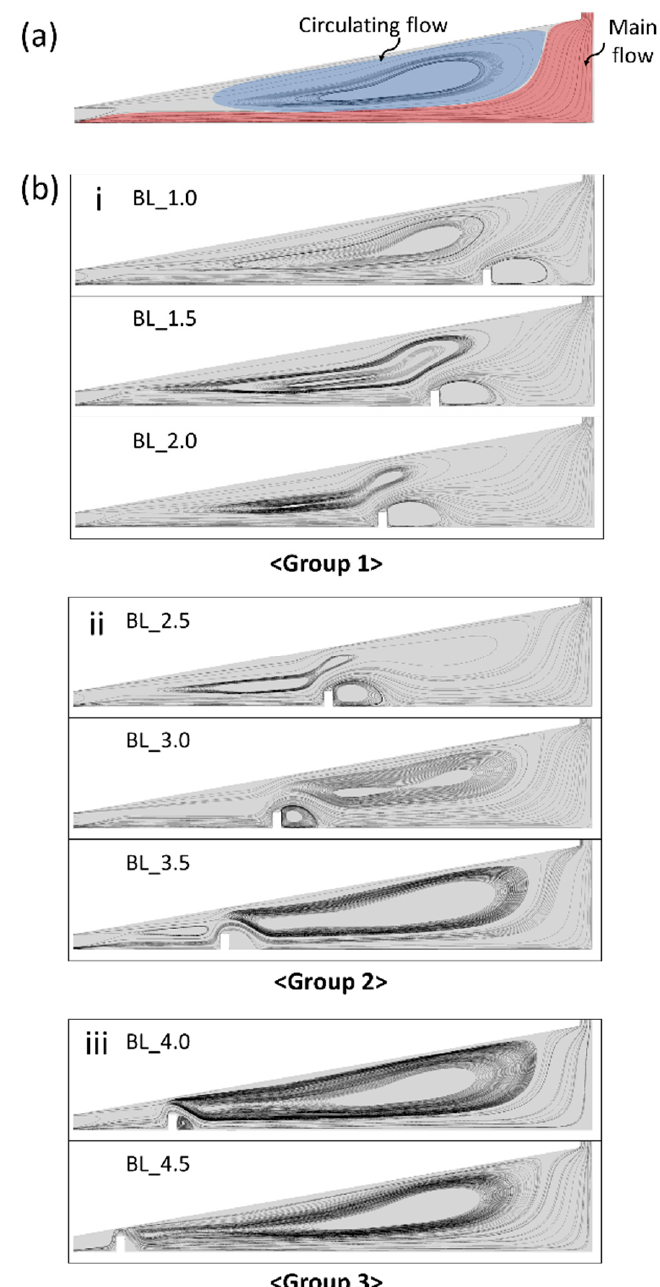
Figure 3. The internal flow field of SUT models with different baffle distances from the center: ( a ) A streamline of the SUT without a baffle, with a flow field classified as “circulating flow” for the circulation streamline and “main flow” for the streamline to the chimney. ( b ) The classification of models with a baffle based on the change of the “circulating flow”: (i) Group 1 includes the “BL_1.0”, “BL_1.5”, and “BL_2.0” models, and its representative model is “BL_1.0”; (ii) Group 2 includes the “BL_2.5”, “BL_3.0”, and “BL_3.5” models, and its representative model is “BL_2.5”; and (iii) Group 3 includes the “BL_4.0”, and “BL_4.5” models, and its representative model is “BL_4.0”.